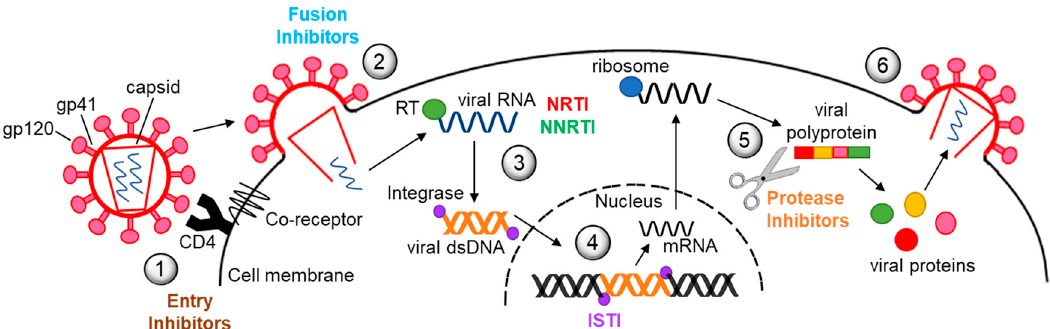
Figure 2. The HIV life cycle and antiretroviral drug targets. ( 1 ) The HIV genome consists of two positive-sense single strand RNA molecules, enclosed by a capsid. The capsid is surrounded by a lipid bilayer envelope which is studded with the viral transmembrane glycoprotein gp41, with viral gp120 positioned on top. Gp120 binds to the cluster of differentiation 4 (CD4) receptor, inducing a conformational change that enables it to then bind to either of two co-receptors on the cell surface, C-C chemokine receptor type 5 (CCR5) or C-X-C chemokine receptor type 4 (CXCR4). ( 2 ) After binding to a coreceptor, the viral envelope fuses with the cell membrane, followed by release of the capsid, genome, and viral proteins into the cytosol. ( 3 ) The RNA genome is reverse transcribed in the cytosol by reverse transcriptase (RT) into linear double-stranded DNA, which is then imported into the nucleus where it ( 4 ) integrates into the cell genome by the action of Integrase. Cell machinery transcribes HIV proviral DNA into single-stranded mRNA that is exported out of the nucleus into the cytoplasm for translation. ( 5 ) Viral assembly begins when HIV protease cleaves viral polyproteins into individual functional proteins. ( 6 ) Viral proteins and the genome are packaged into newly assembled virions that bud from the cell surface, incorporating the lipid bilayer of the host cell membrane. The color coding for drug classes established in Figure 1 is maintained here, and class names are positioned in the figure where they act within the life cycle. To date, there are no medications that block viral budding. NRTI = nucleoside reverse transcriptase inhibitor; NNRTI = non-nucleoside reverse transcriptase inhibitor; ISTI = integrase strand transfer inhibitor.